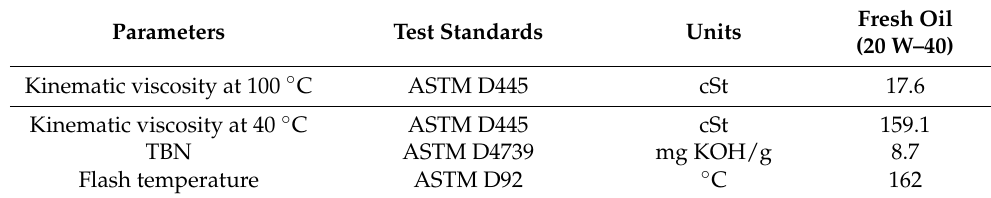
Figure 1 . Representation of the experimental setup . Figure 1. Representation of the experimental setup. Table 1. Lubricant oil properties. Table 1. Lubricant oil properties.